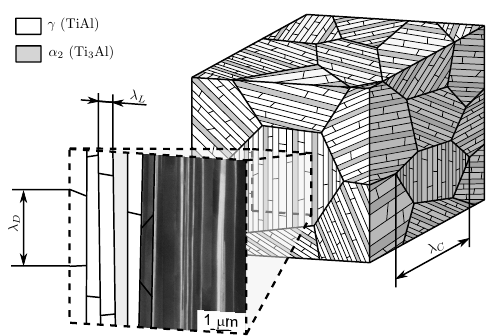
Figure 1. Schematic illustration of fully lamellar microstructure with magnification of lamellae. λ L : lamella thickness; λ D : domain size; λ C : colony size. (SEM micrograph: courtesy of Michael Oehring, Helmholtz-Zentrum Geesthacht)